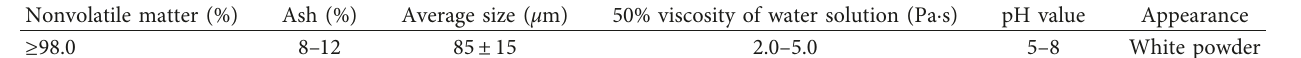
Table 3: Performance parameters.